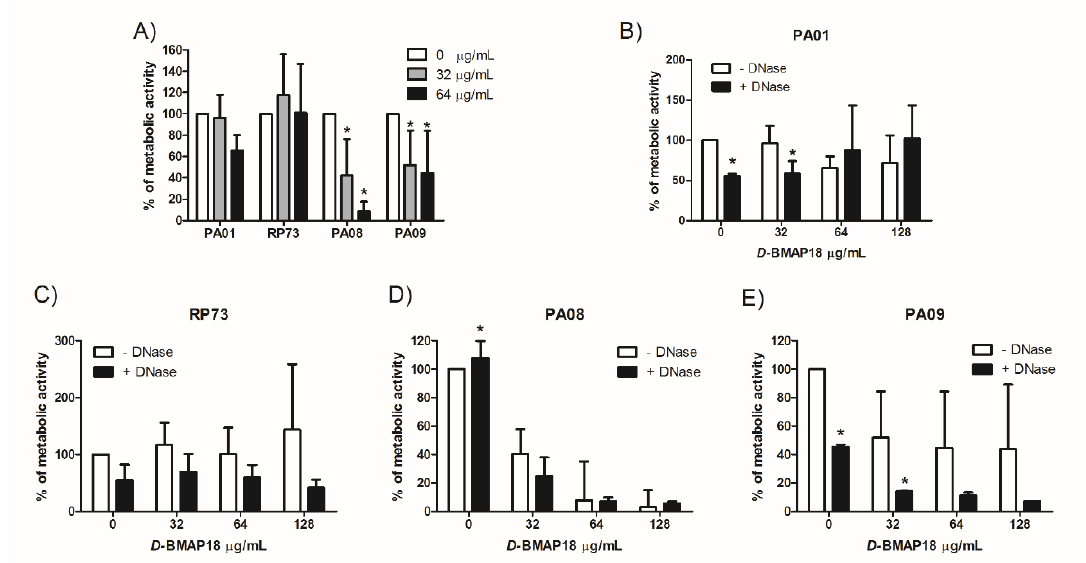
Figure 3. Biofilm eradication activity of D -BMAP18. MTT viability test on preformed biofilms has been performed on four P.a. strains using the peptide at 4× and 8× MIC values ( A ). Assays have been also performed after 1h pretreatment with (+) or without (-) DNase I (128 μg/mL) on PAO1 ( B ), RP73 ( C ), PA08 ( D ), and PA09 ( E ) strains. Percentage of metabolic active biofilm after 24h treatment